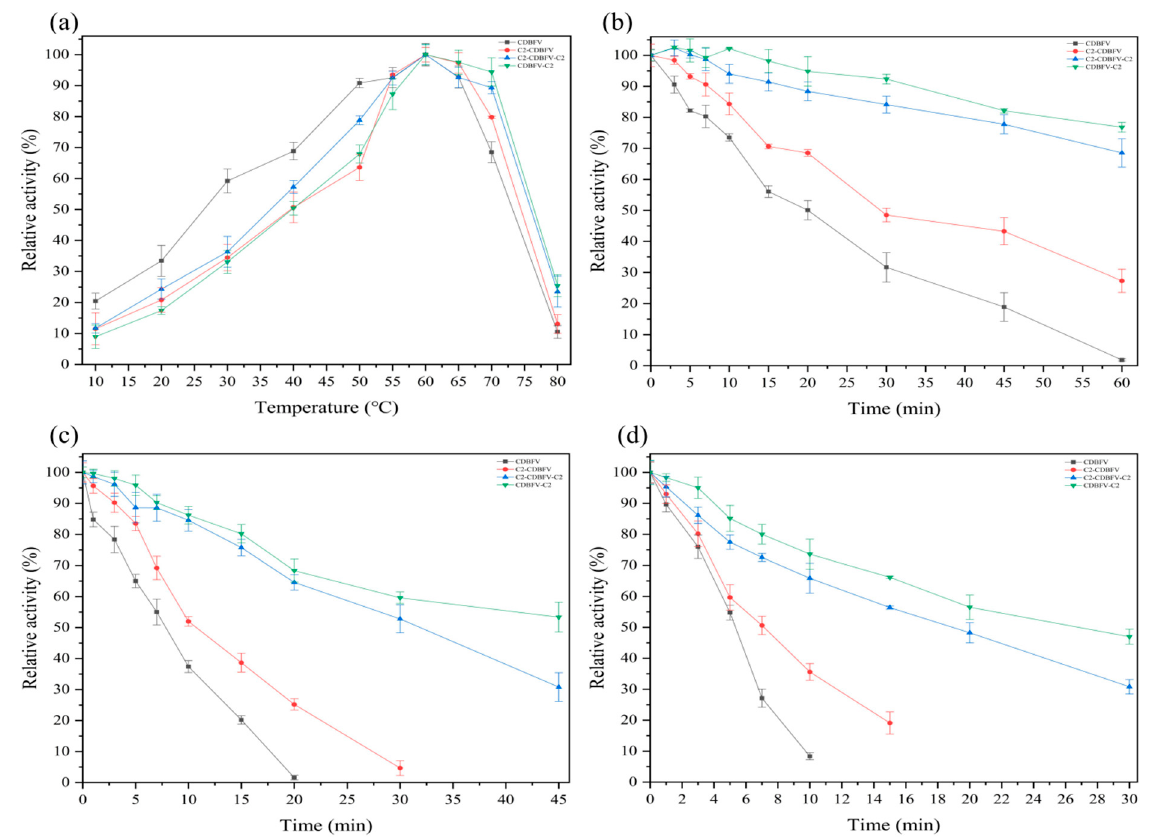
Figure 2. Temperature characterization of four purified xylanases. ( a ) Effect of temperature on enzyme activity: the enzymatic activity was determined at different temperatures of 10.0–80.0 °C and pH 5.5. The enzyme activities of CDBFV, C2-CDBFV, CDBFV-C2, and C2-CDBFV-C2 at pH 5.5 were 1062, 1251, 1260, and 1358 U/mg, respectively, which were defined as 100.0%. ( b ) Temperature stability at 60.0 °C: incubation of the enzymes for 60.0 min at 60.0 °C. ( c ) Temperature stability at 65.0 °C: incubation the enzymes CDBFV-C2 and C2-CDBFV-C2 for 45.0 min, the enzyme C2-CDBFV for 30.0 min, and the enzyme CDBFV for 20.0 min. ( d ) Temperature stability at 70.0 °C: incubation of the enzymes CDBFV-C2 and C2-CDBFV-C2 for 30.0 min, the enzyme C2-CDBFV for 15.0 min, and the enzyme CDBFV for 10.0 min. The enzyme activities of CDBFV, C2-CDBFV, CDBFV-C2, and C2-CDBFV-C2 at pH 5.5 and 60.0 °C were 1062, 1251, 1260, and 1358 U/mg, respectively, in the absence of any treatment, and these values were defined as 100.0%. Relative activity was defined as the percentage of measured high enzyme activity. All values in this research are presented as the mean ± SD of triplicate experiments.